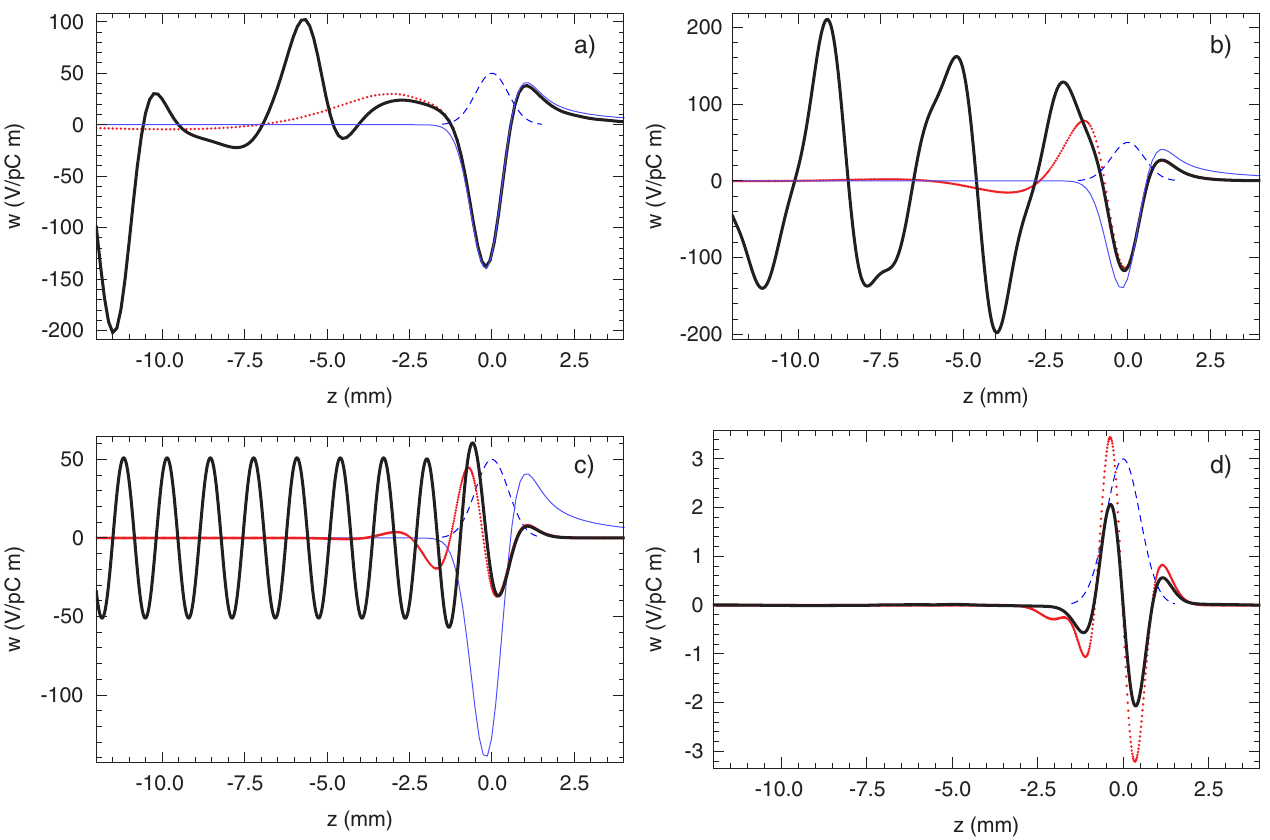
FIG. 4. (Color) Steady state wakefields in the toroid for the aspect ratio A ¼ 1 and various values of b : (a) b ¼ 4 cm , (b) b ¼ 2 cm , (c) b ¼ 1 cm , and (d) b ¼ 0 : 5 cm